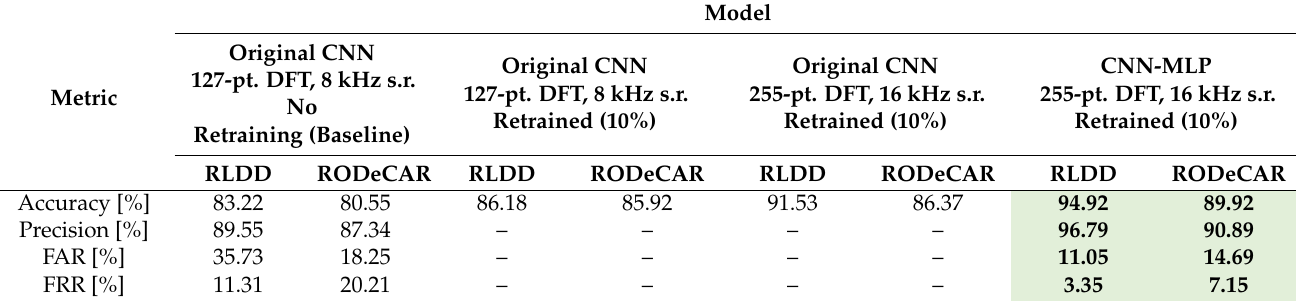
Table 4. VAD frame-level cross-validation performance vs. model type–RLDD and